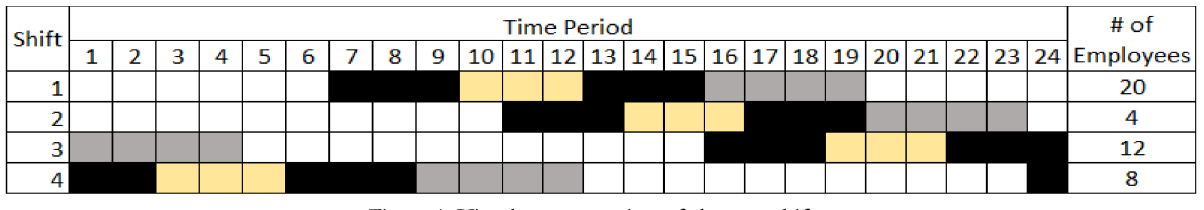
Figure 1. Visual representation of the new